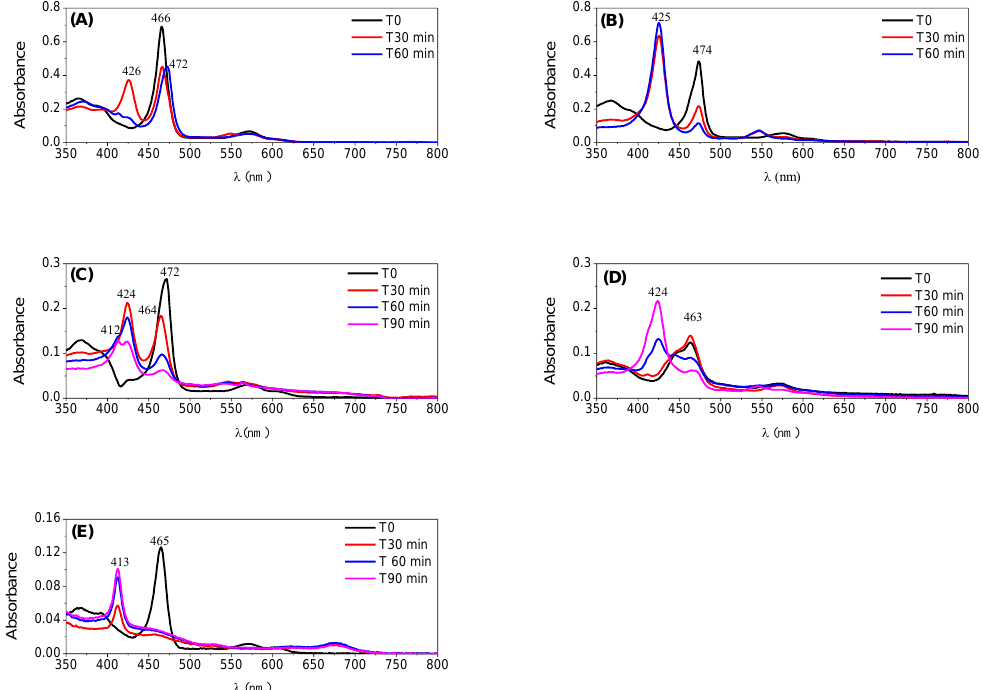
Figure 8. UV – VIS monitoring of the catalysts along cyclooctene oxidation reactions for the S/C molar ratio of 150: ( A ) CAT-2 ; ( B ) CAT-4 ; ( C ) CAT-5 ; ( D ) CAT-3 ; and ( E ) CAT-6 .